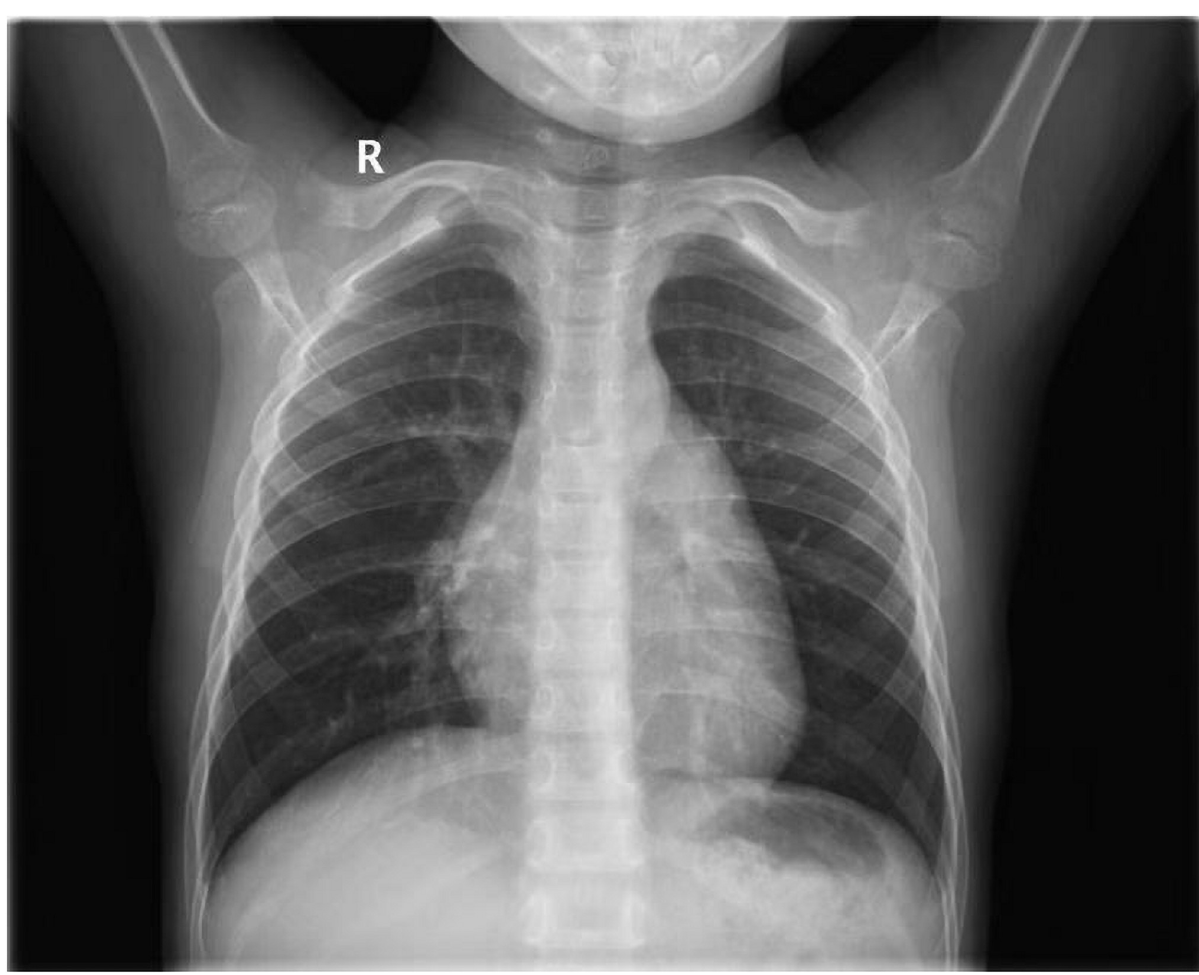
Fig 4. Chest DR image of a pediatric participant in the standing APP group (unit A). The image shown is that of a 40-month-old female with a height of 105 cm, a weight of 17 kg, and a BMI of 15.42 kg/m 2 . The ESD value was 0.06 mGy, the DAP value was 0.20 dGy•cm 2 , the VGAS was 29, the right LFA was 68.95 cm 2 , the left LFA was 49.82 cm 2 , the total LFA was 118.77 cm 2 , and the LD was 12.77